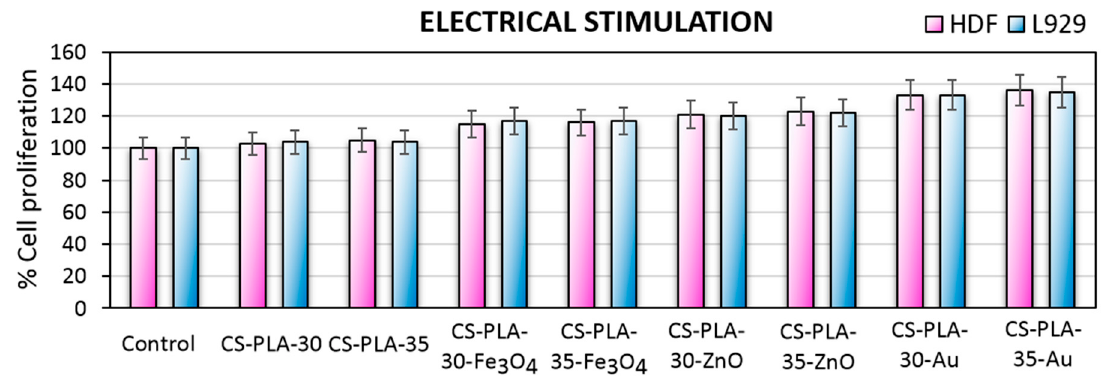
Figure 13. Metabolic activity of L929 mouse fibroblasts cell line and human dermal fibroblasts (primary cells) after electro-stimulated cell culture.